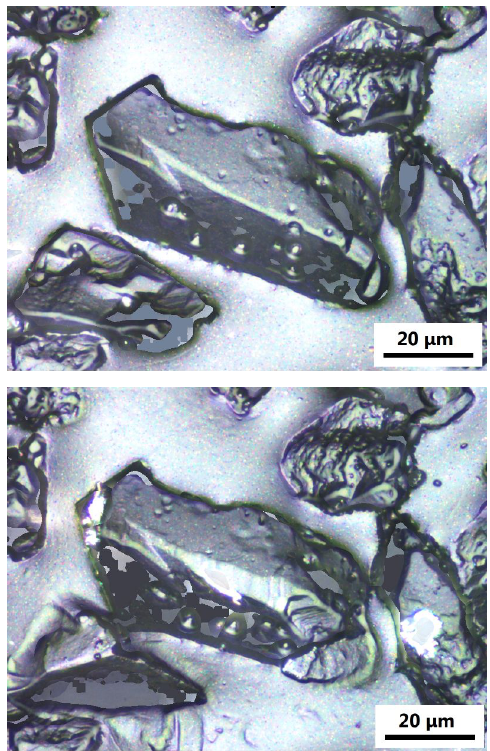
Figure 4. Abrasive grain before grinding ( top ) and after grinding ( bottom ): visible wear due to grain grinding and grain crushing (view obtained from